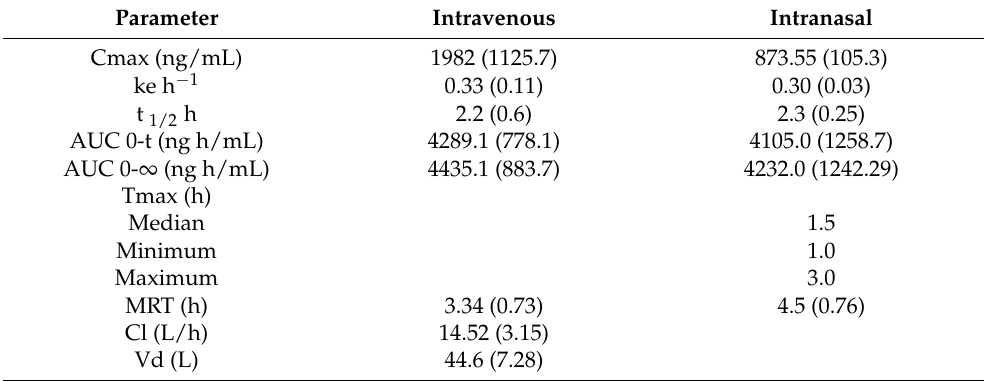
Table 4. Mean pharmacokinetic parameters (sd) of MEP after intravenous and intranasal administration.